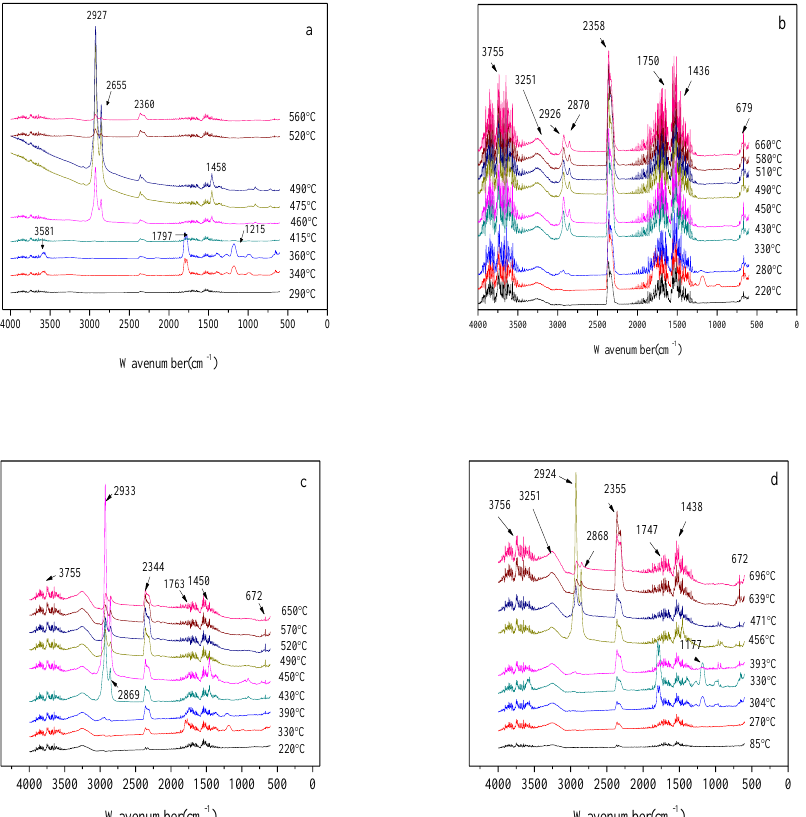
Figure 11. FTIR spectra of pyrolysis products of: ( a ) EVA, ( b ) EFMgO, ( c , d ) ELDH-1 and ELDH-2 samples at different temperatures.